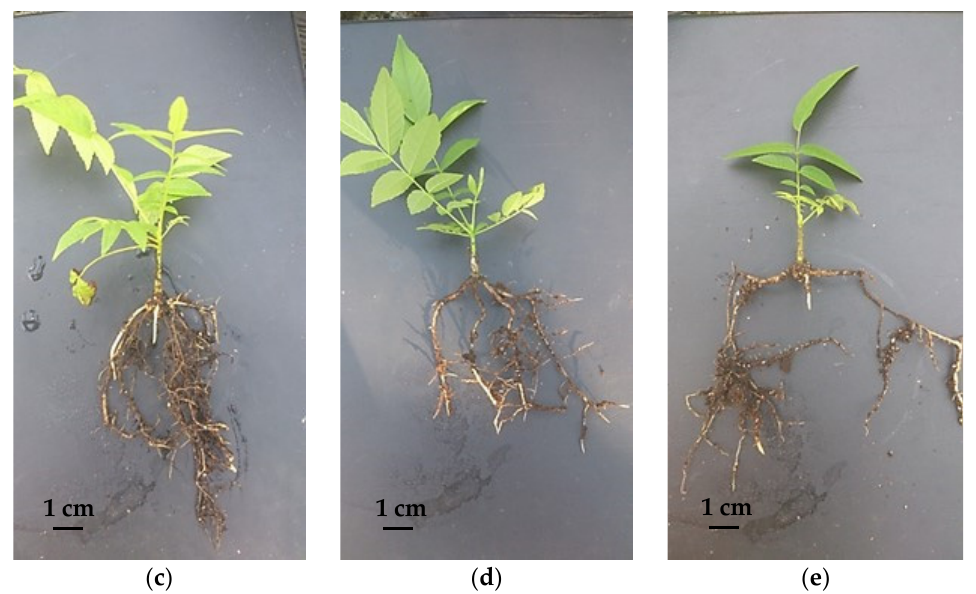
Figure 2. Morphological differences in root systems of Juglans hybrid progeny clones of Mj209 × Ra at 3 weeks ( a , b ) and 7 weeks ( c – e ) after root initiation of microshoots cultured in root expression media supplemented with fructose ( a , d ), glucose ( b , e ), and sucrose ( c ) (The concentrations used are summarized in Table 1). Photos provided by R.J. Licea-Moreno.